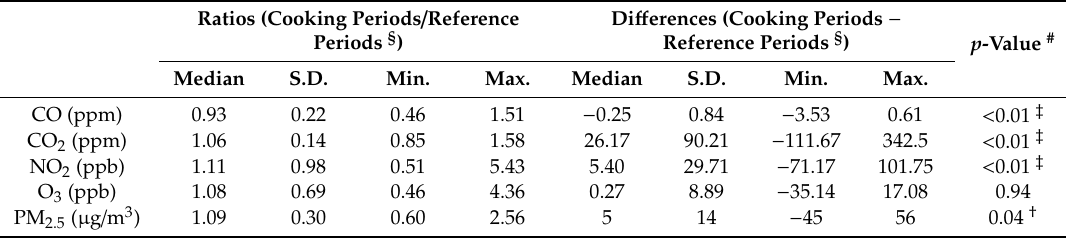
Table 4. The ratios of air pollutants during cooking periods to reference periods and the di ff erences in air pollutants between during cooking periods and reference periods. Ratios (Cooking Periods / Reference Di ff erences (Cooking Periods − Periods § ) Reference Periods § )